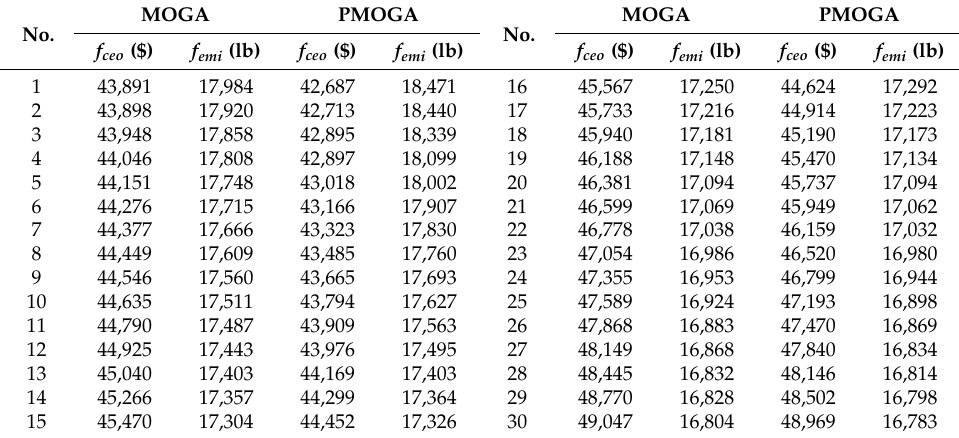
Table 6. The non-dominated schemes obtained by different methods for Case 3.